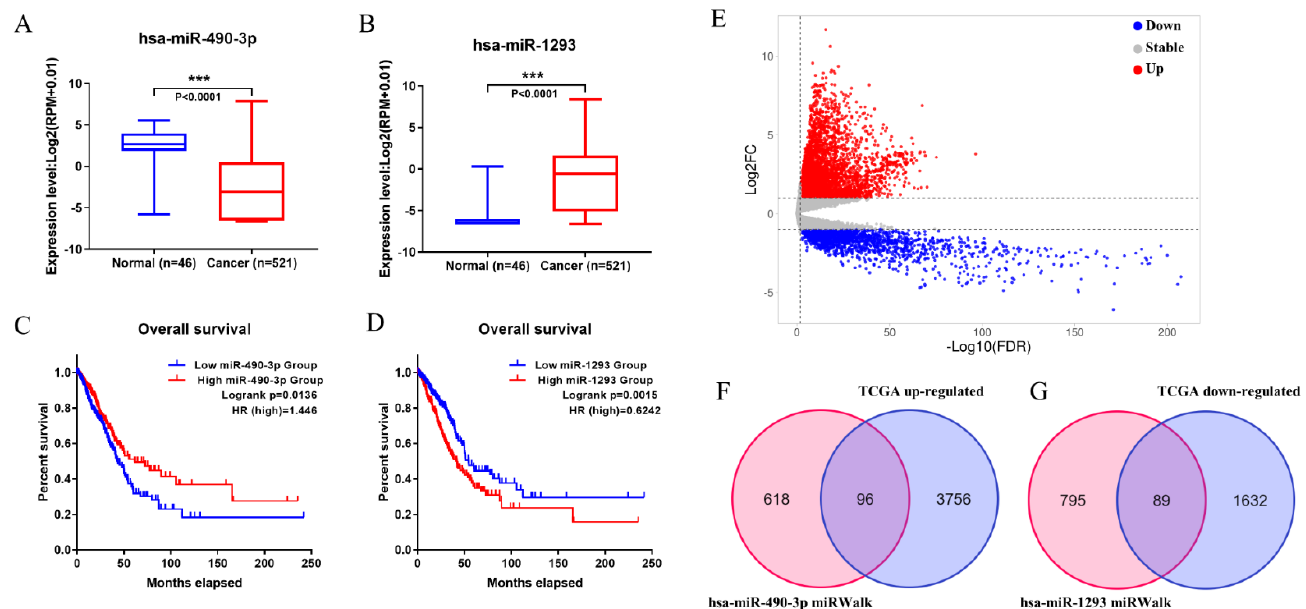
Figure 4. The expression level and OS time of 2 miRNAs, and target genes were predicted. ( A , C ) has-miR-490-3p. ( B , D ) has-miR-1293. ( E ) Volcano plots for differentially expressed mRNAs in LUAD derived from the TCGA database. ( F , G ) Intersecting the predicted target genes and DEGs, respectively. “ *** ” means p < 0.001.